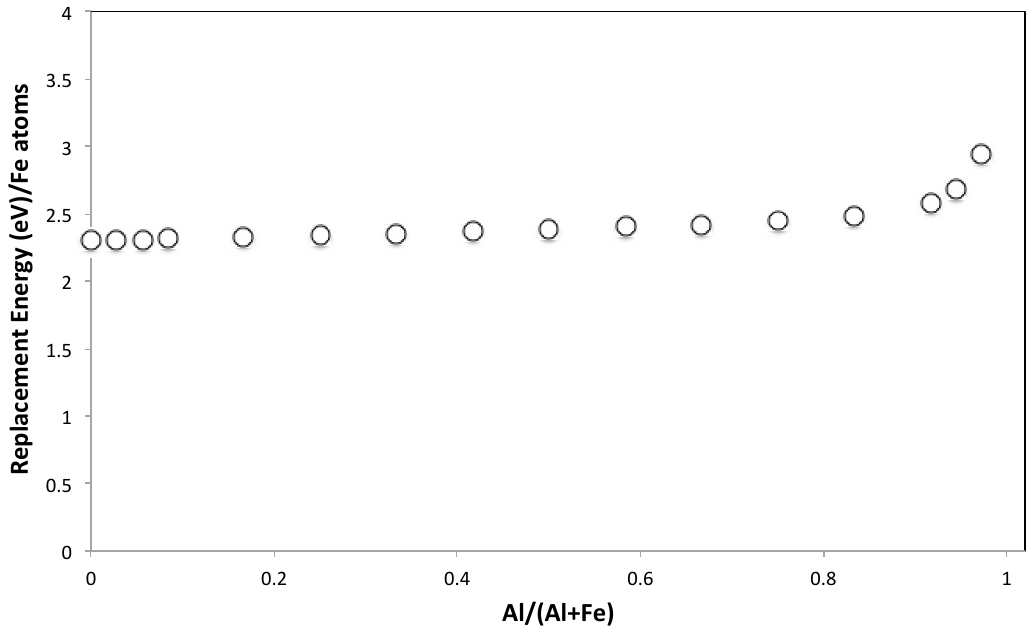
Figure 11. Replacement energy (eV)/Fe ions substituted versus Al mole fraction.